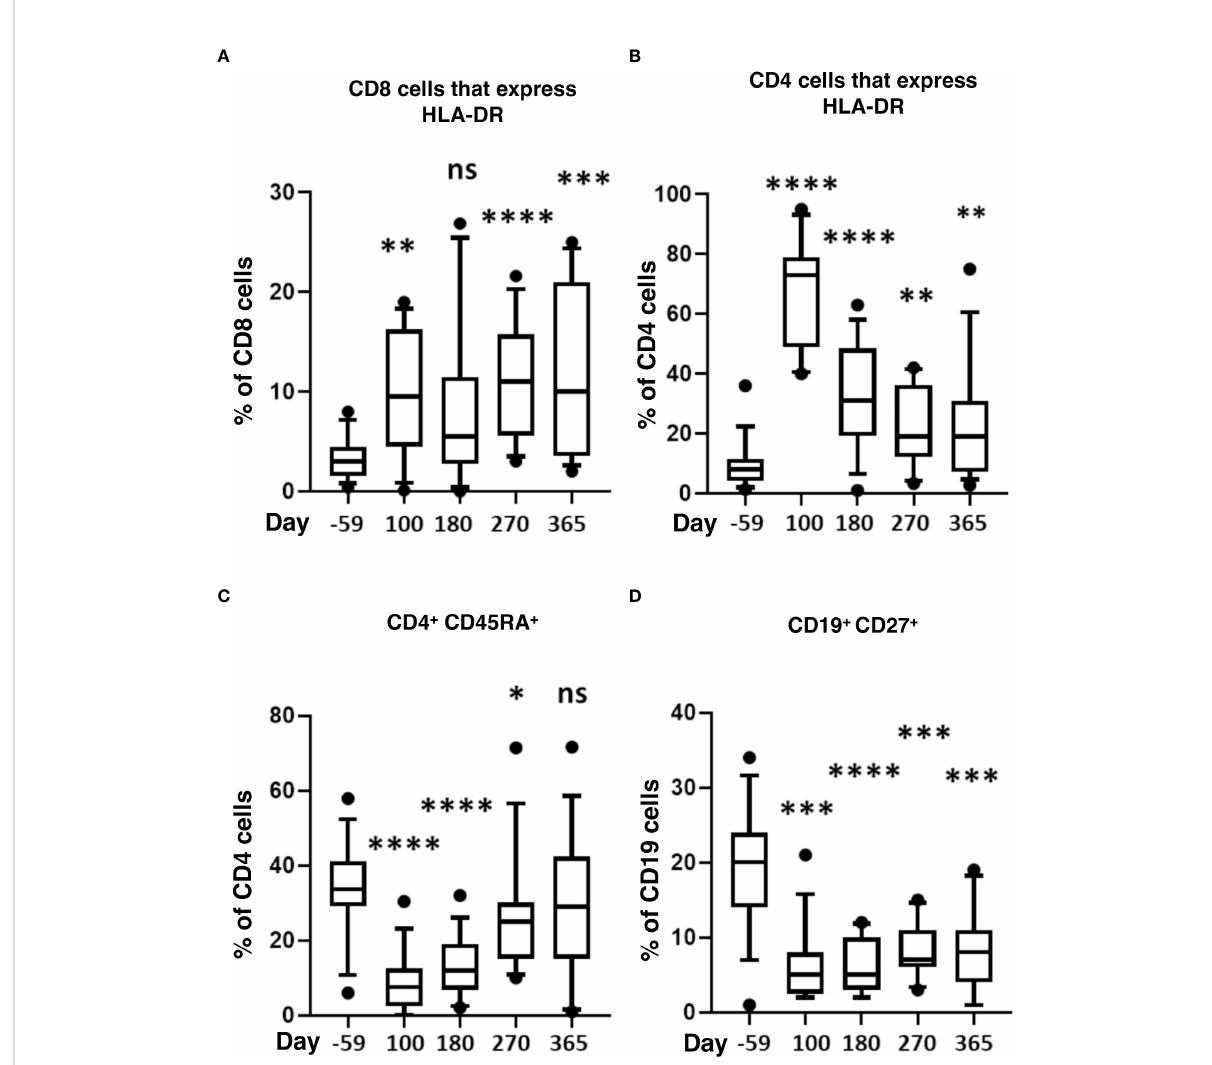
FIGURE 4 Markers of T-cell activation and memory after HISCT. The percentage of HLA-DR + in CD8 (A) , the percentage of HLA-DR + in CD4 (B) , and the percentage of CD45RA + in CD4 T cells (C) is shown at baseline and indicated time points after HISCT. (D) the percentage of CD27 + in CD19 + B cells shown at baseline and indicated time points. Statistically signi fi cant differences between baseline and post-HSCT timepoints are indicated as **** P<0.0001, *** P<0.005, ** P<0.001, * P<0.05. ns, not signi fi cant; HSCT, hematopoietic stem cell transplantation; HLA, human leucocyte antigen; HISCT, haploidentical stem cell